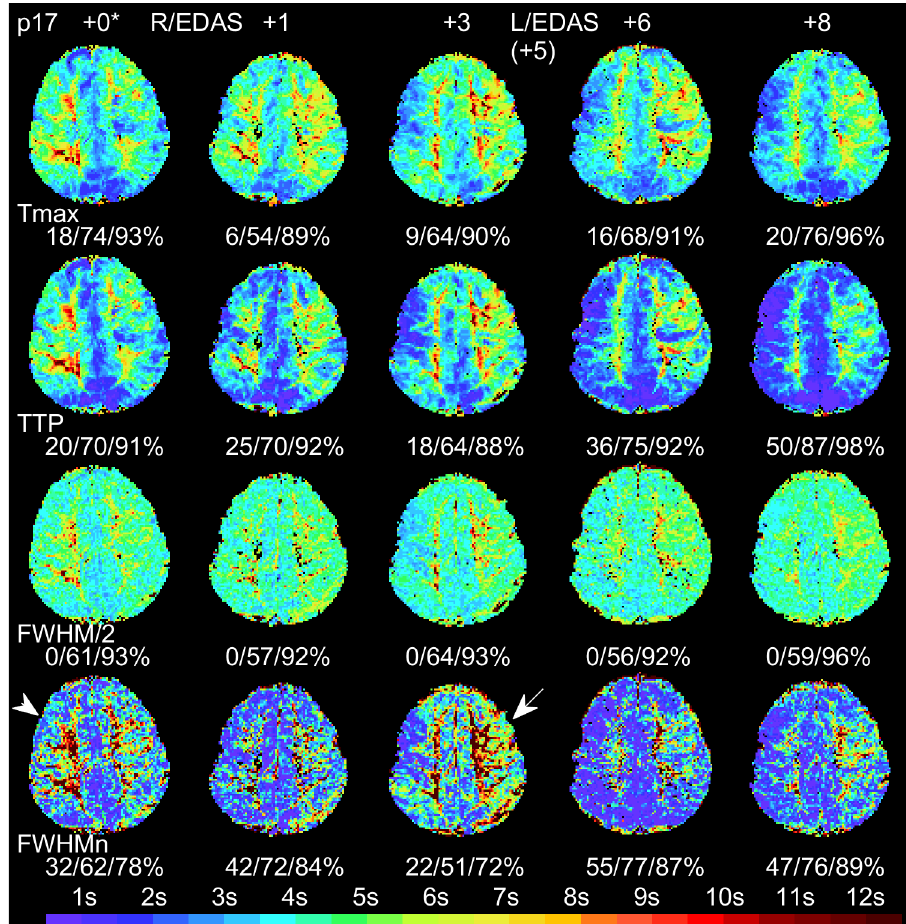
Figure 3. Representative perfusion maps of a 12-year-old boy (patient 17 in Table 1) who underwent a right EDAS operation first and a left EDAS five months later. Normalized delay time areas at thresholds of 2, 4, and 6 s are given under each map. Tmax (first row, derived by SVD +M ) shows modest perfusion improvement while TTP (second row) indicates more improvement. FWHM/2 (third row) shows consistent pattern in green color. FWHM n (fourth row) becomes narrower gradually on the right hemisphere (arrow head) but wider at month + 3 on the left hemisphere (arrow), and narrower